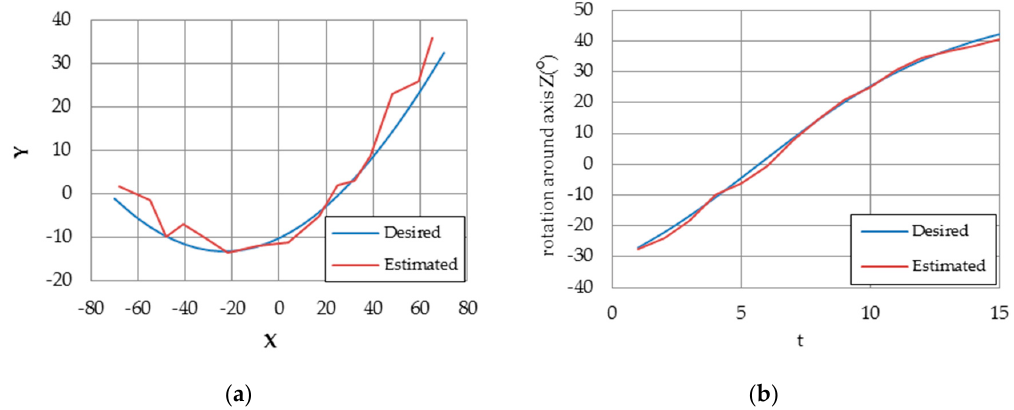
Figure 23. ( a ) Blue line represents the followed path and red represents the estimated pose; ( b ) estimated rotation in red where the real rotation in blue. ( b ) estimated rotation in red where the real rotation in blue. Table 3. Comparison of relative pose estimation errors. Table 3. Comparison of relative pose estimation errors.